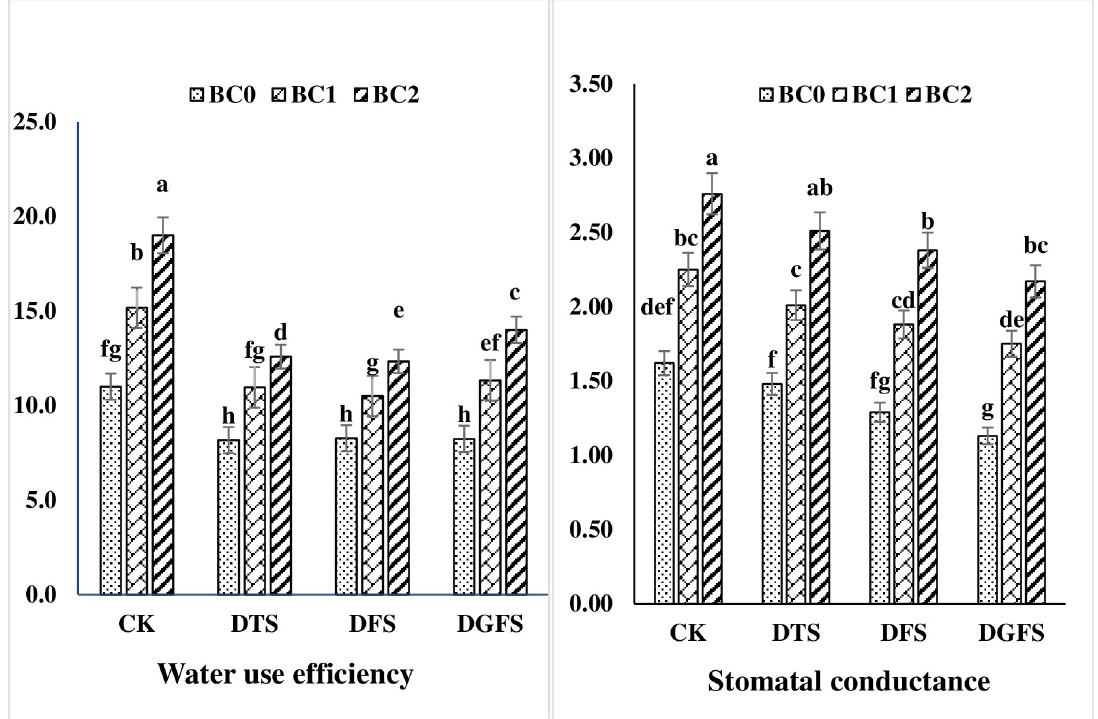
Fig 1. Water use efficiency (%) and stomatal conductance (m mol -2 s -1 ) contents affected by biochar application under drought stress at critical growth stages of wheat. CK, DTS, DFS and DGFS indicates control, drought at tillering, flowering and grain filling stages respectively. BC 0 , BC 1 and BC 2 indicates control, 3% and 5% biochar respectively. Error bars indicates standard error (n =